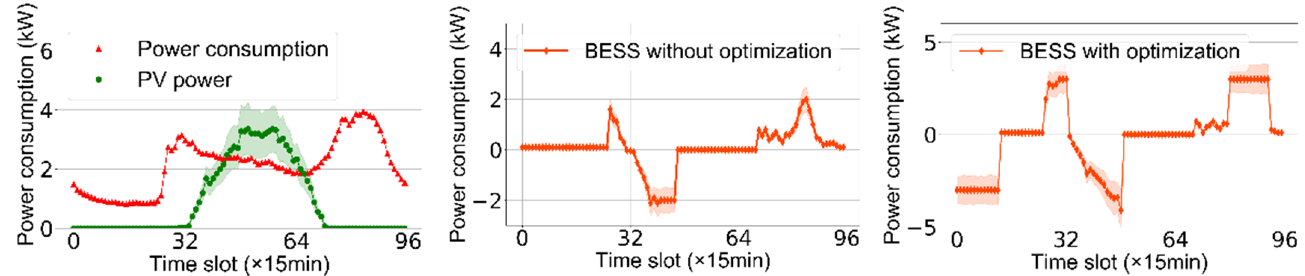
Figure 8. Power consumption, PV power, and BESS power of consumer I .